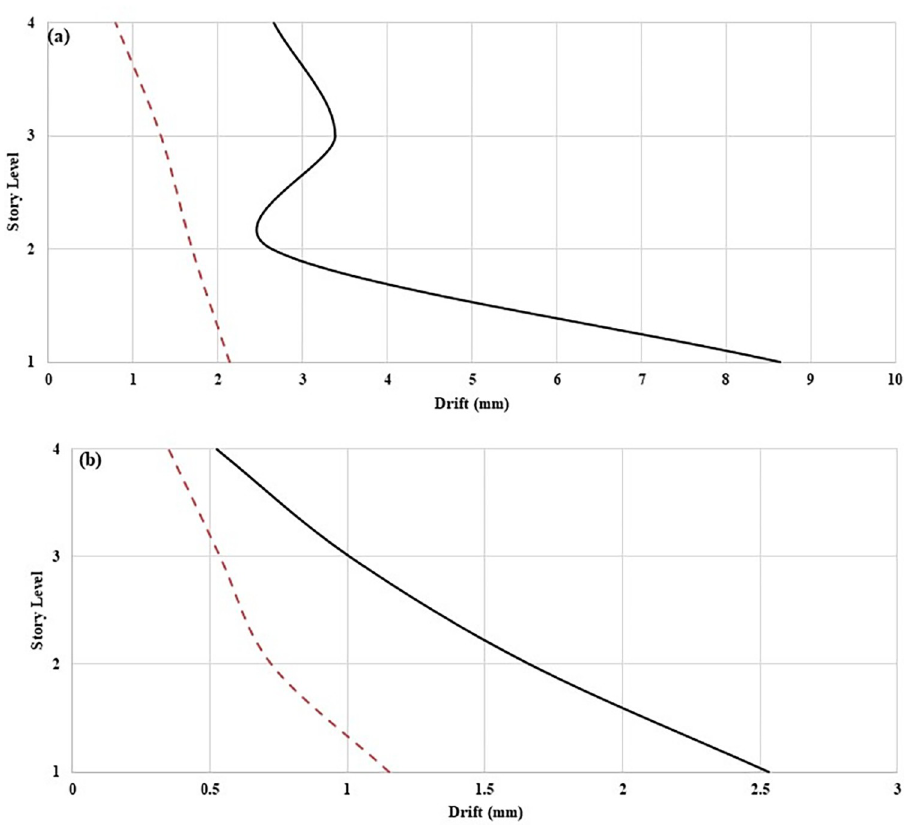
Fig 10. RMS inter-storey drifts responses of MDOF structure equipped with and without TLCD at (a) Resonant loading, and (b) Seismic loading.